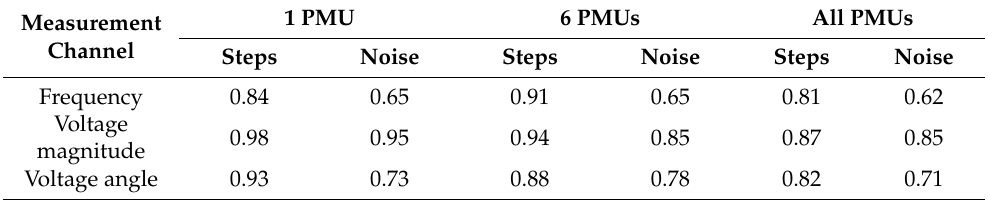
Table 4. Total F1-scores of the GRU-FC model for different PMU step and noise manipulations. Measurement